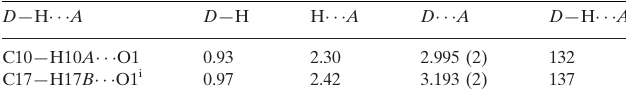
Hydrogen-bond geometry (A˚ , (cid:2)